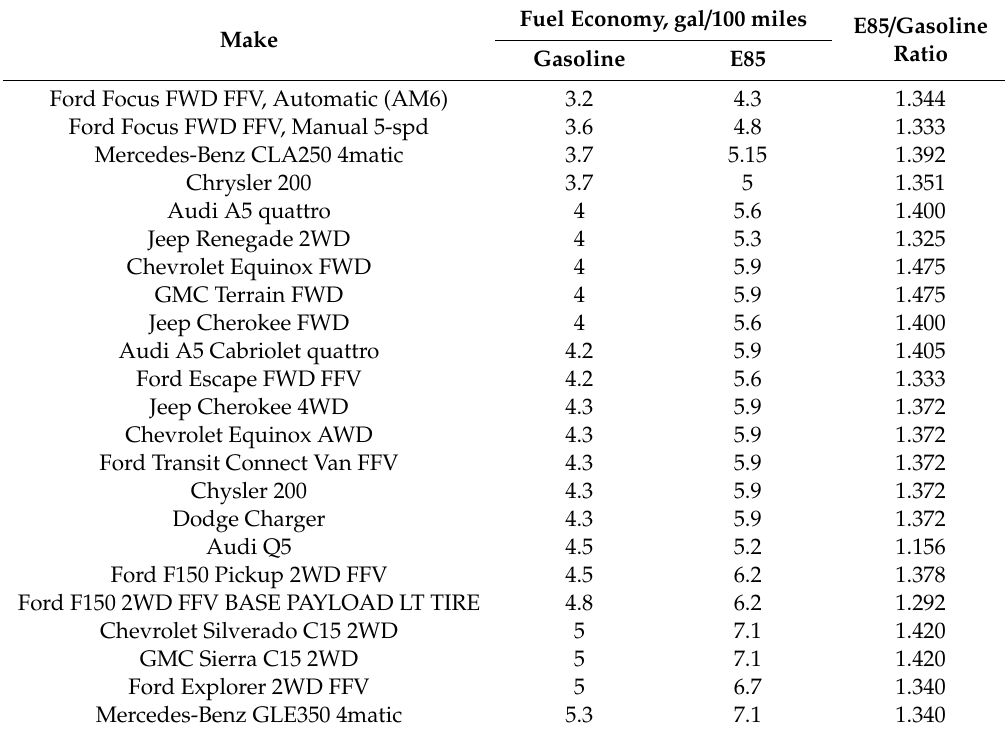
Table 1. Fuel economy (adapted from